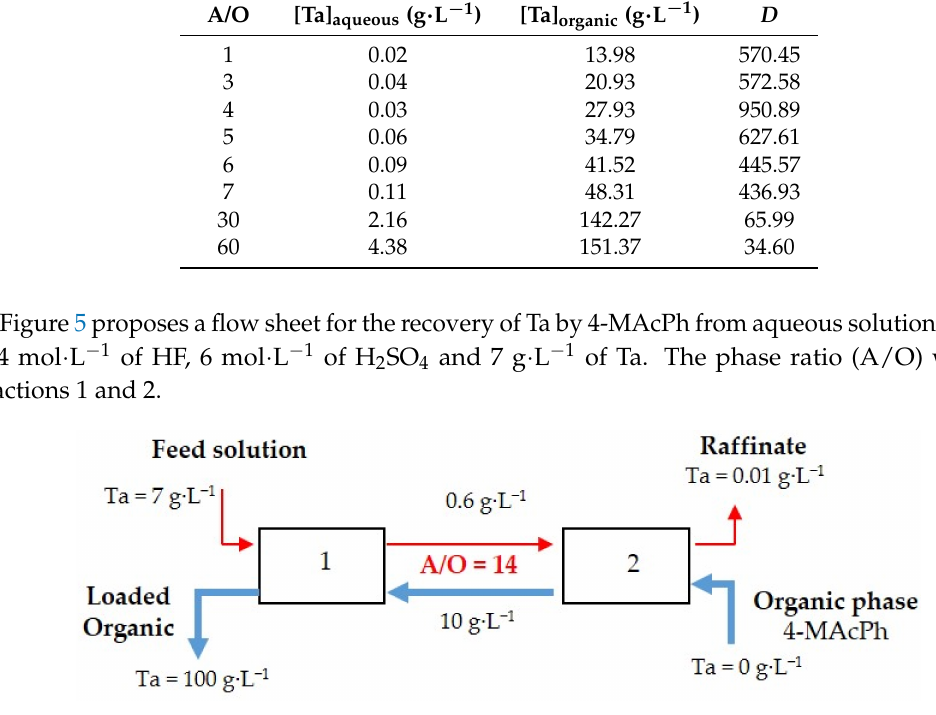
Figure 5. Flow sheet for Ta recovery by 4-MAcPh with two stages at A/O =